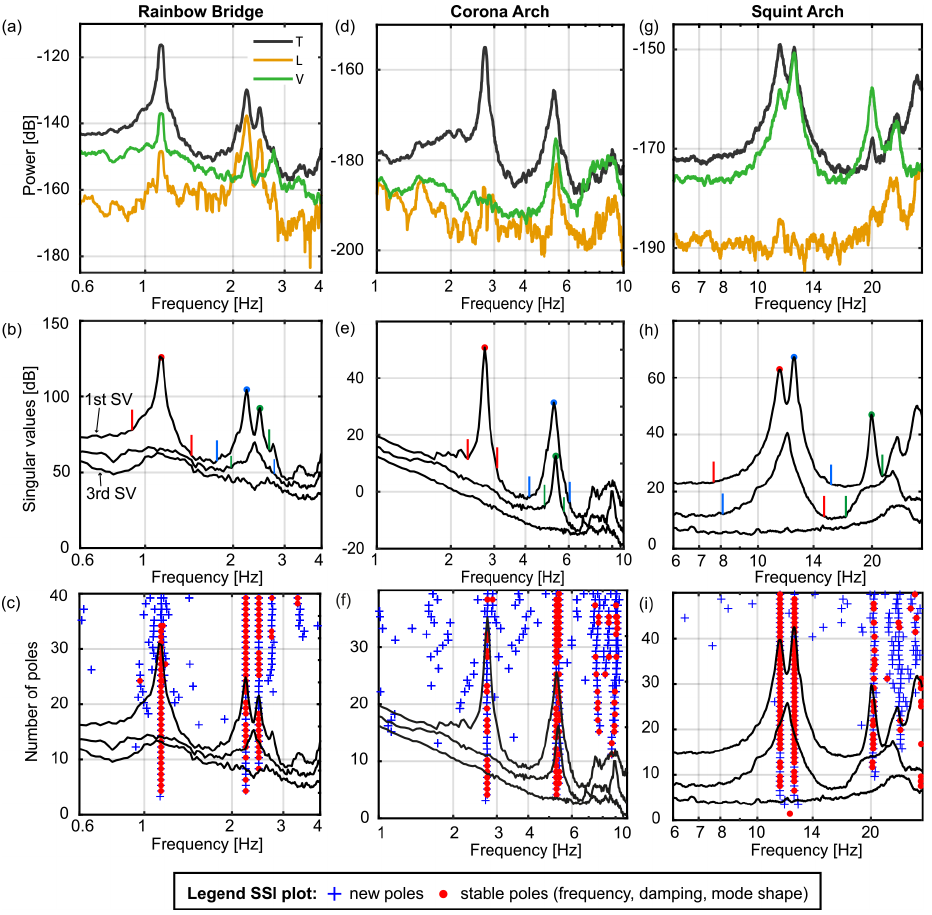
Figure 3. (a) Power spectra of Rainbow Bridge and (b) singular value (SV) plot of EFDD analysis at Rainbow Bridge. The largest SV always represents the first SV (top line). Solid markers indicate the resonant peaks, while vertical colored lines indicate the extent of the corresponding mode bell. (c) Singular value plot of Rainbow Bridge with SSI-COV poles superimposed with an increasing number of poles. Each pole is marked with a blue cross; stable poles (in terms of resonant frequency, mode shape, and damping ratio) are marked with a red circle. Unstable poles (i.e., blue crosses at distance from stable poles) arise from noise fitting. Panels (d–f) and (g–i) are the same as (a–c) for Corona Arch and Squint Arch,